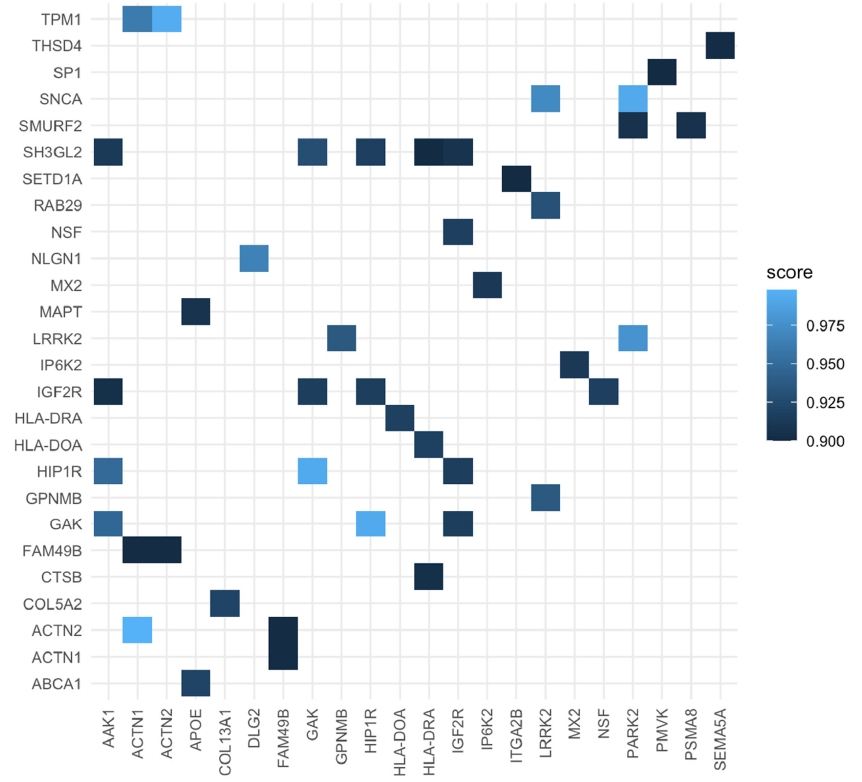
Figure 2. Heatmap of proteins. Table 1. Score results between Parkinson’s disease (PD) and periodontitis related proteins identified in the network interaction.